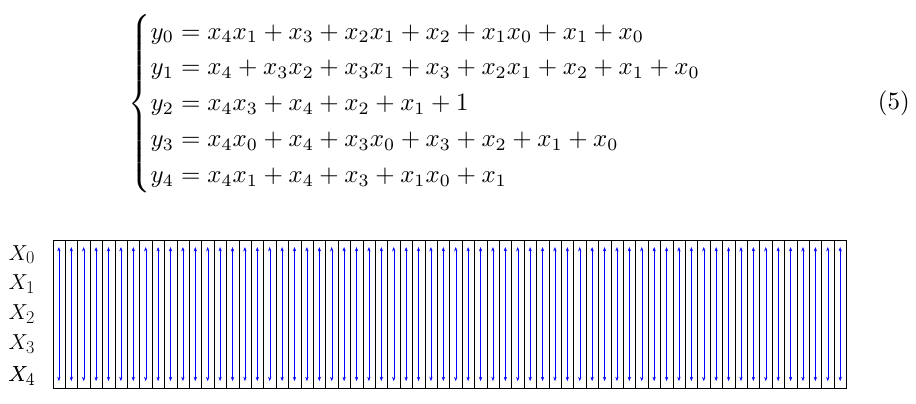
Figure 3: Substitution layer p S